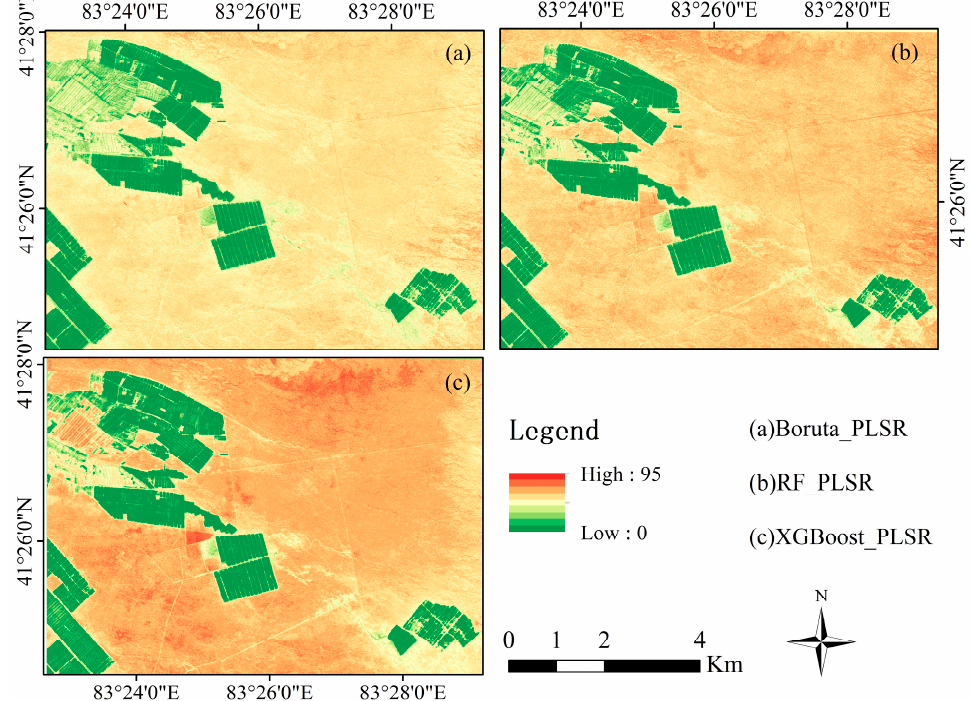
Figure 9. Digital soil electrical conductivity (EC) spatial distribution map.